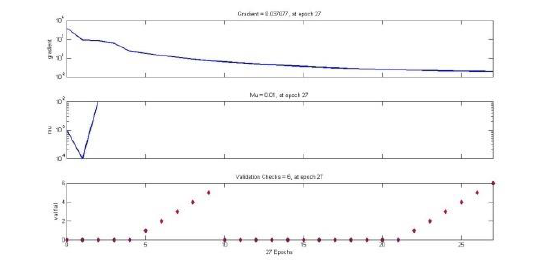
Figure 13: Performance histogram where blue line represents train data, green line represents validation data and red line represents test data. Gradient is equal to 0.037077 at iteration 27 and µ is equal to 0.01 at iteration 27 (see Figure 14).